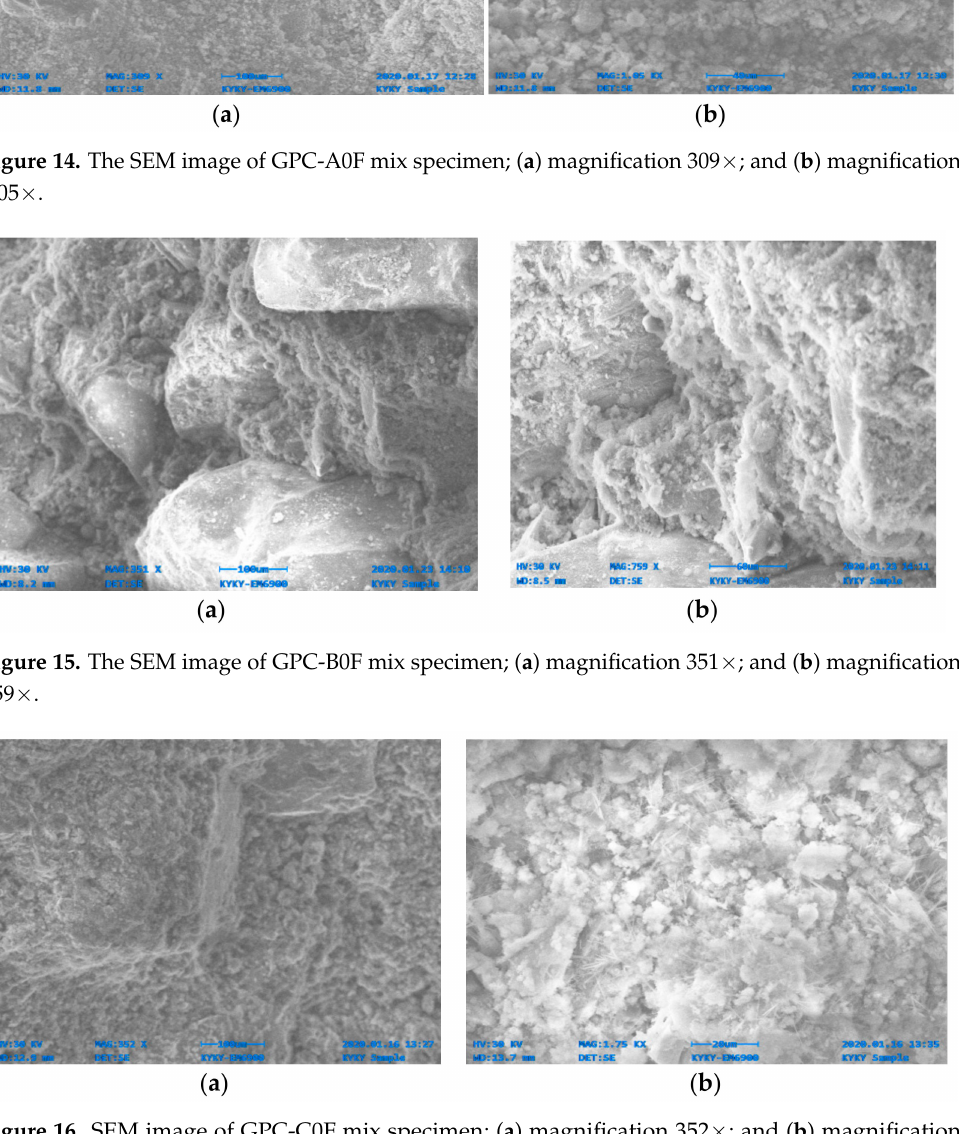
Figure 16. SEM image of GPC-C0F mix specimen; ( a ) magnification 352 × ; and ( b ) magnification 1.75 ×